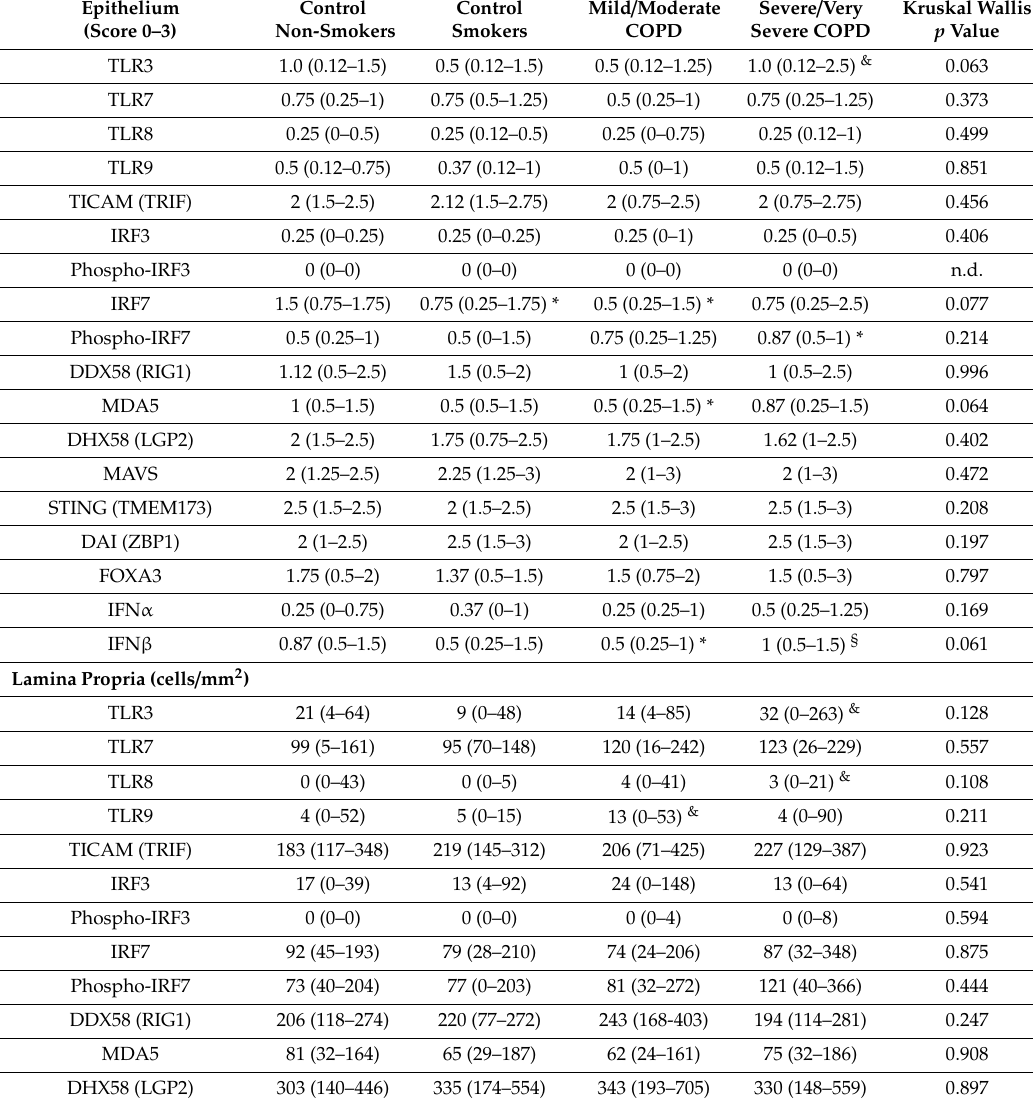
Table 3. Immunohistochemical quantification of inflammatory cells, innate immune molecules, and cytokines related to viral response in bronchial